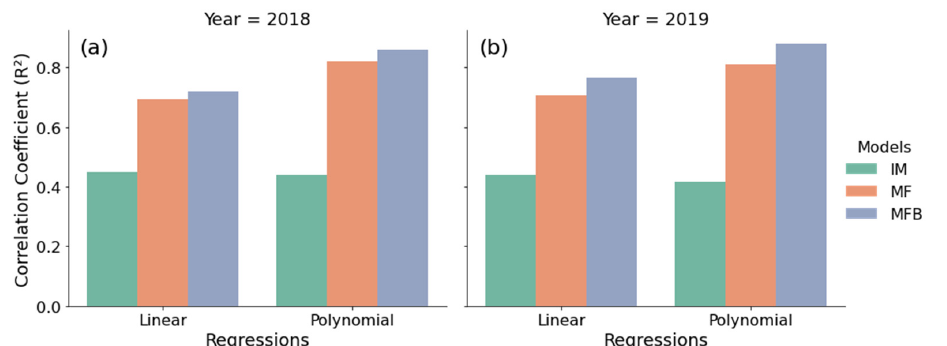
Figure 7. Modelling accuracy comparison before and after modifications (IM is the initial model, MF is the mowing ratio modified model, MFB is the model modified by both mowing ratio and bare ground metrics): ( a ) modeling accuracy comparison in 2018; ( b ) modeling accuracy comparison in 2019.